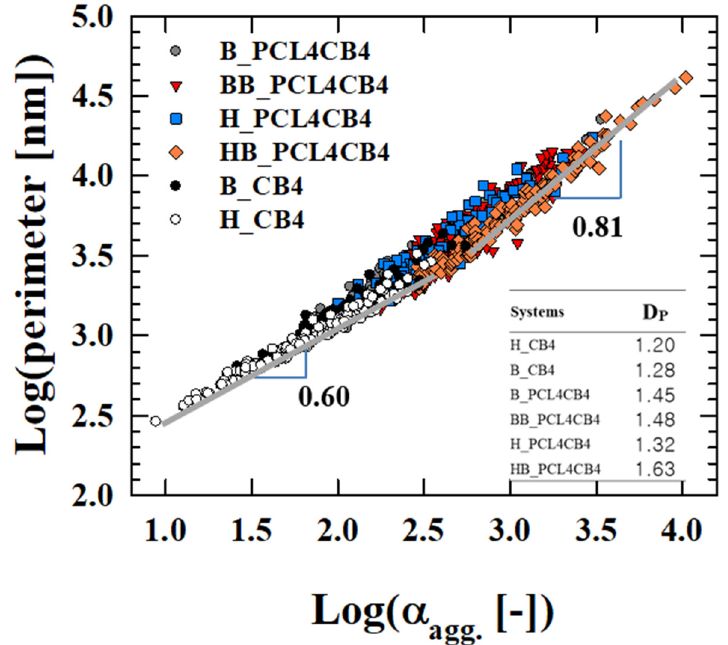
Figure 6. Plots of perimeter vs. α agg. of CB aggregates in binary and ternary composites depending on the mixing method. The inset table lists the perimeter-based fractal dimension (D p ) for the composites. As D p deviates from 1.0, the CB aggregates show a more irregular shape, deviating from spherical and show a branched structure if it exceeds 1.32 [26].